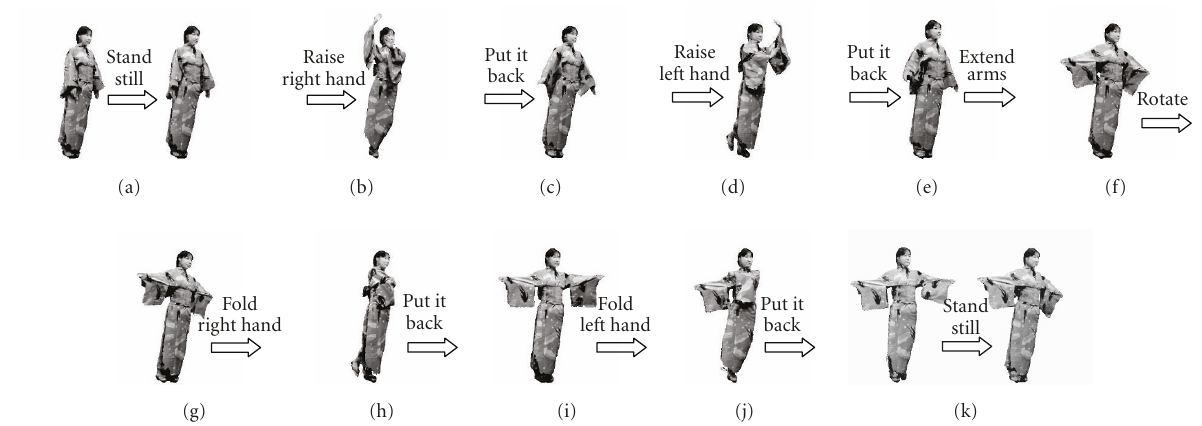
Figure 4: Subjective segmentation results for sequence #1 by eight volunteers.